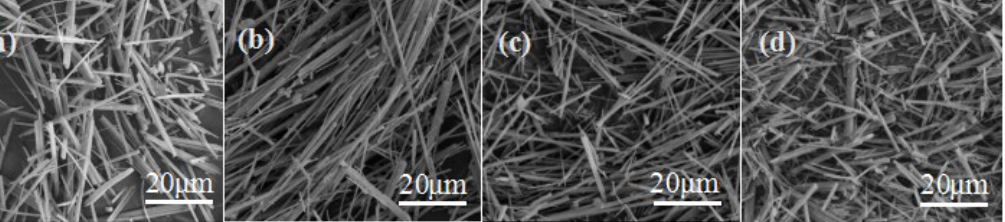
Figure 6. ESEM photos of CSHW at different stirring speeds: ( a ) 100 rpm, ( b ) 200 rpm, ( c ) 300 rpm, ( d ) 400 rpm.